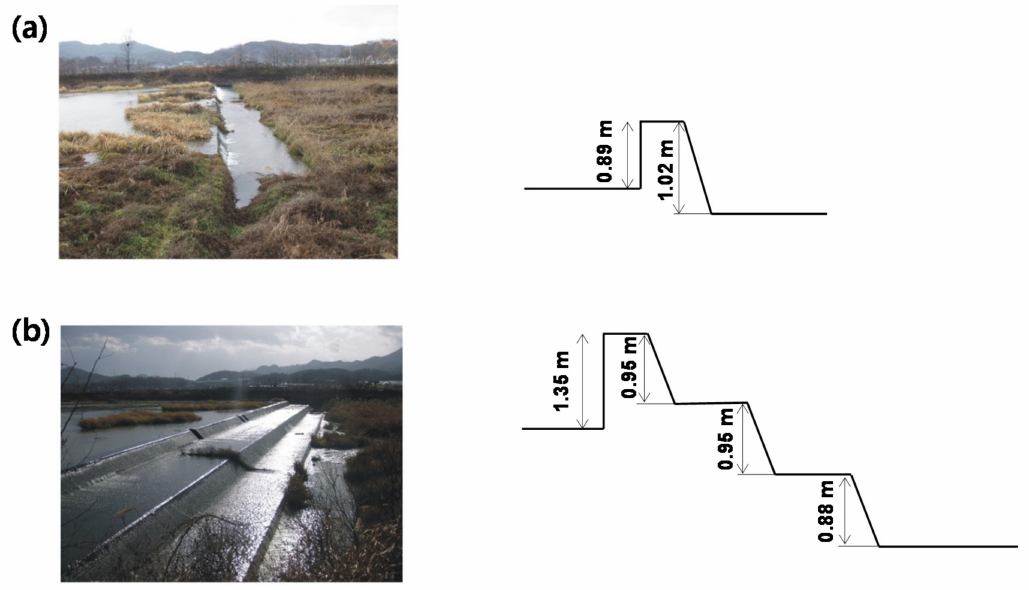
Figure 2. Photographs of weirs ( a ) and ( b ) and their conceptual crosscut